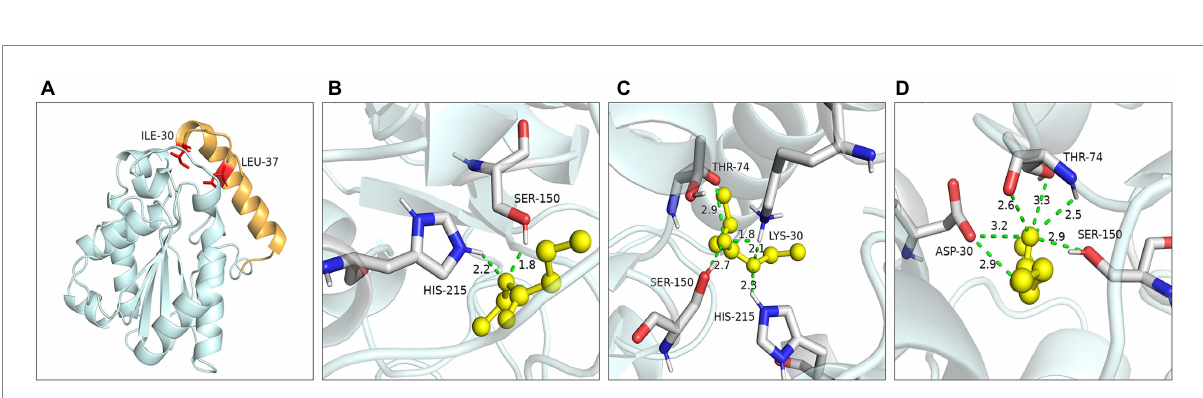
FIGURE 4 Catalytic function analysis of key residues of the lid domain. (A) Spatial position of Ile30 and Leu37. (B) Molecular docking of LIP05 to ethyl butyrate. (C) Molecular docking of I30K to ethyl butyrate. (D) Molecular docking of I30D to ethyl